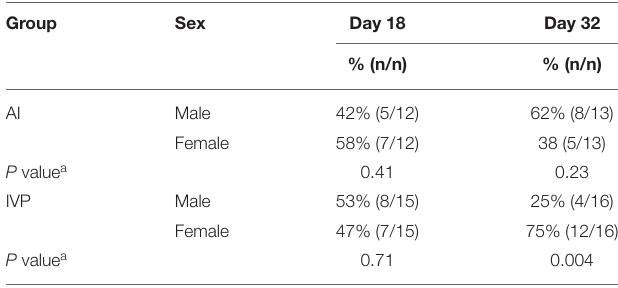
TABLE 1 | Sex ratio for embryos from artificial insemination (AI) or produced in vitro (IVP) on days 18 and 32 of